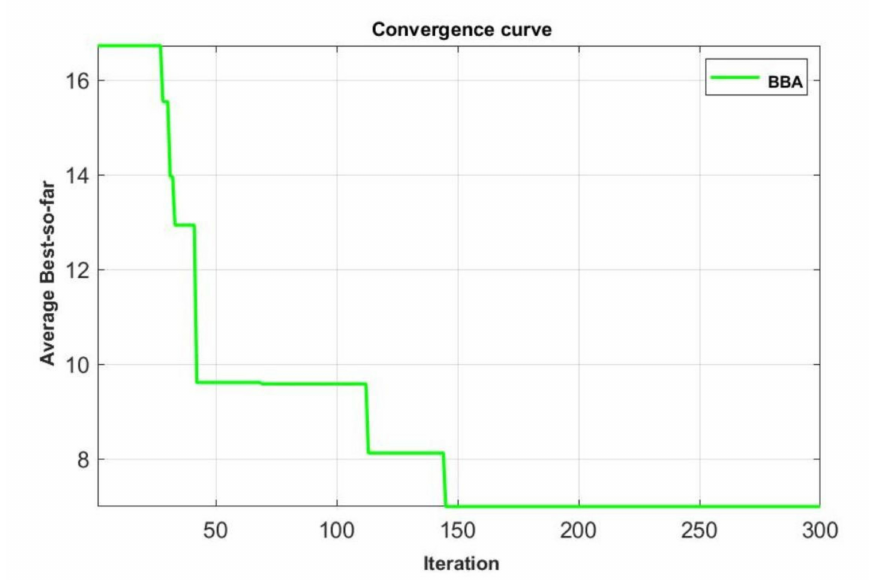
Figure 4. Convergence curve for an optimal number and location of voltage dip devices for three- phase short